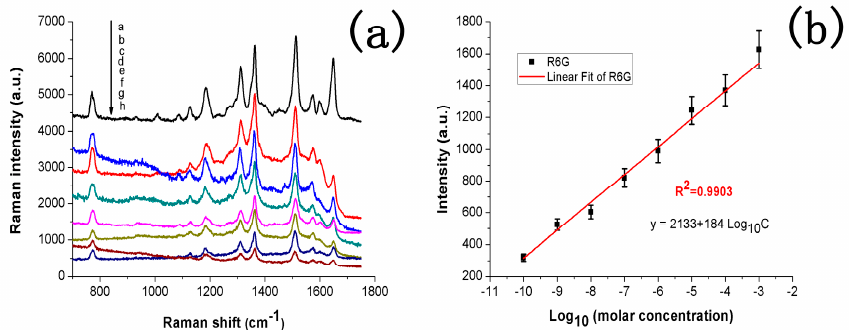
Figure 4. ( a ) SERS signals of R6G, at different concentrations ranging from 10 − 3 to 10 − 10 mol/L, absorbed on AgNP-decorated PS PC samples. ( b ) Corresponding linear fitting of Raman intensity at 1512 cm − 1 with logarithmic R6G concentration. Error bars present the standard deviation obtained from three independent measurements. ( λ excitation 633 nm, acquisition time 3 s, laser power 1 mW).